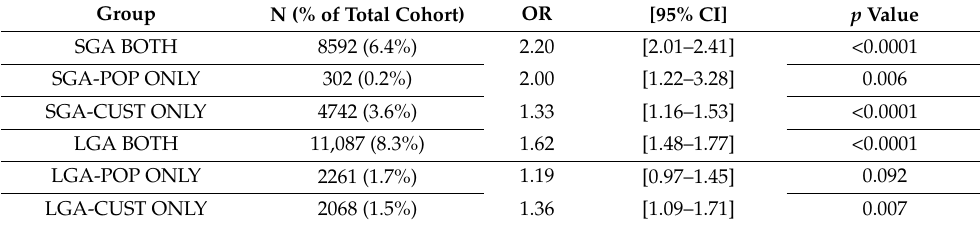
Table A4. Multivariable logistic model for composite adverse outcome.